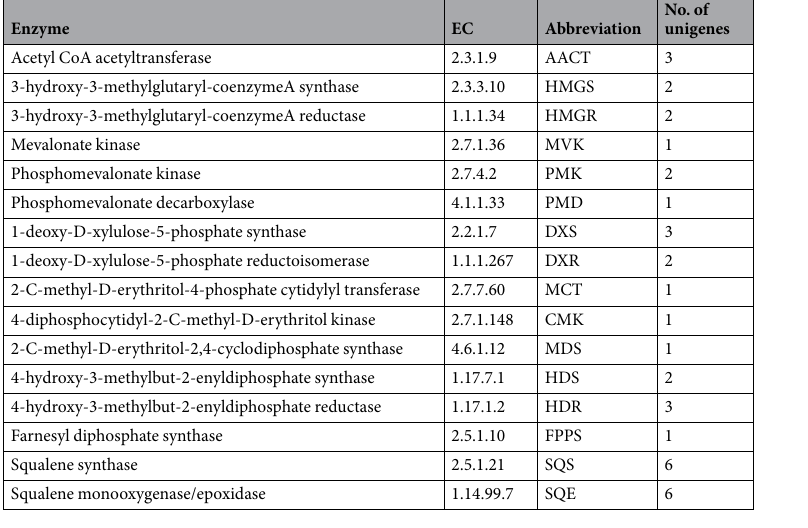
Table 2. Details of enzymes involved in triterpenoid